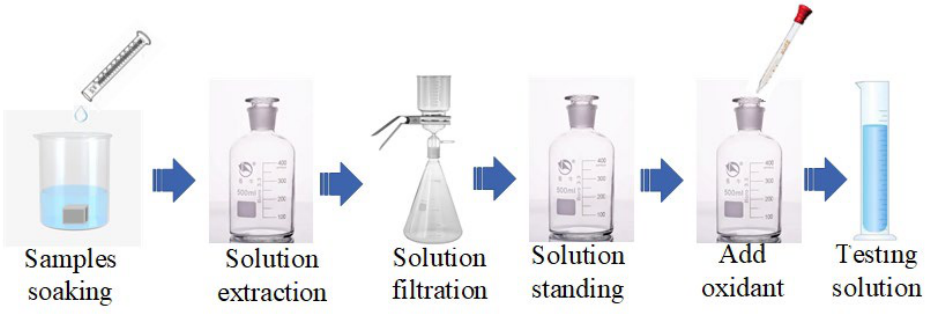
Figure 8. Schematic diagram of leaching tests .